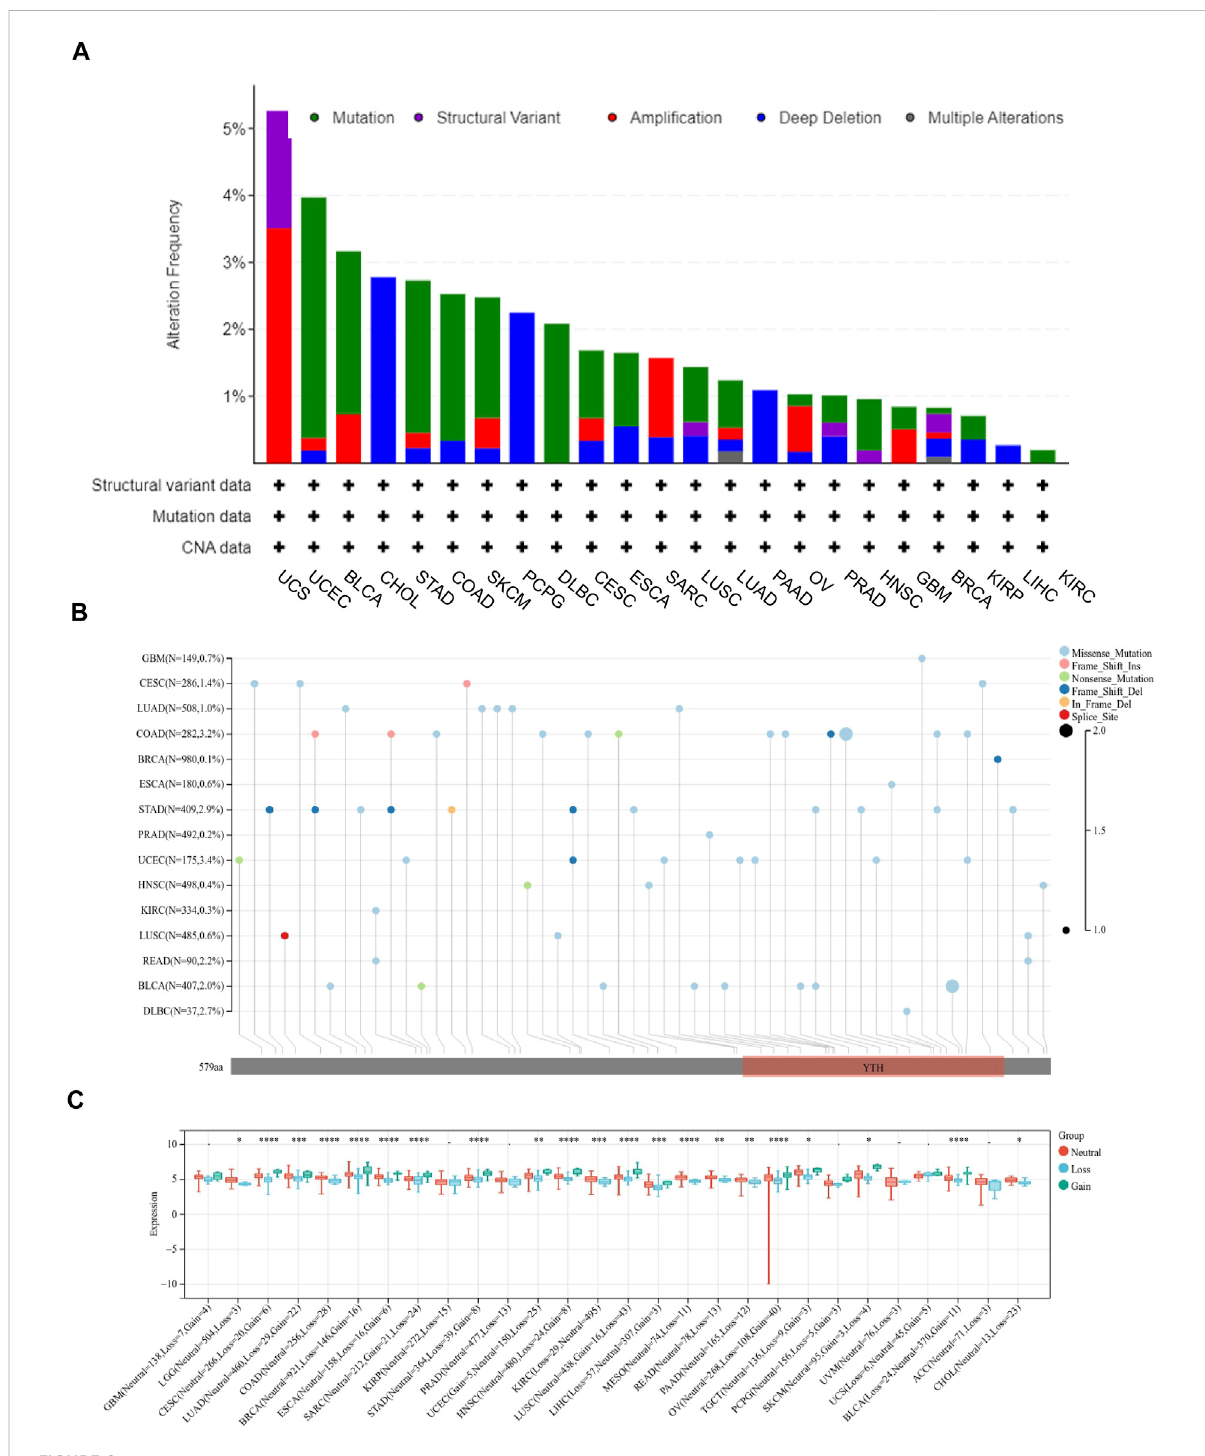
FIGURE 2 The mutation of YTHDF2 in cancers analyzed using TCGA data. (A) The mutation frequency and types of YTHDF2 in different cancer types. (B) The mutation information of YTHDF2 in different cancers. (C) The correlation between YTHDF2 expression and CNV. * p < 0.05, ** p < 0.01, *** p <